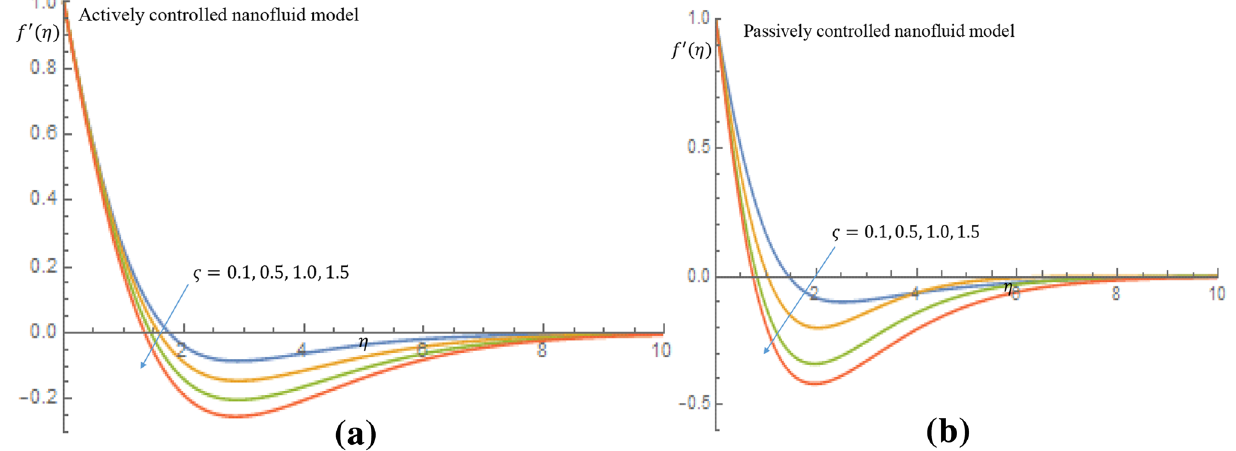
Figure 14. ( a ) Effect of ς on velocity profile when P e = 2.0 . ( b ) Effect of ς on velocity profile when P e = 2.0 .